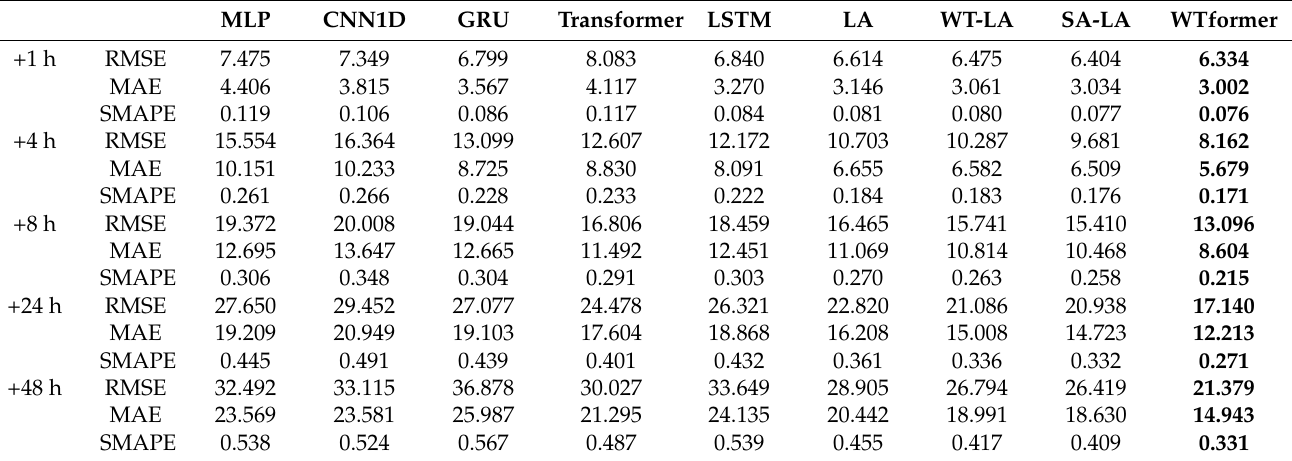
Table 2. Comparison of model